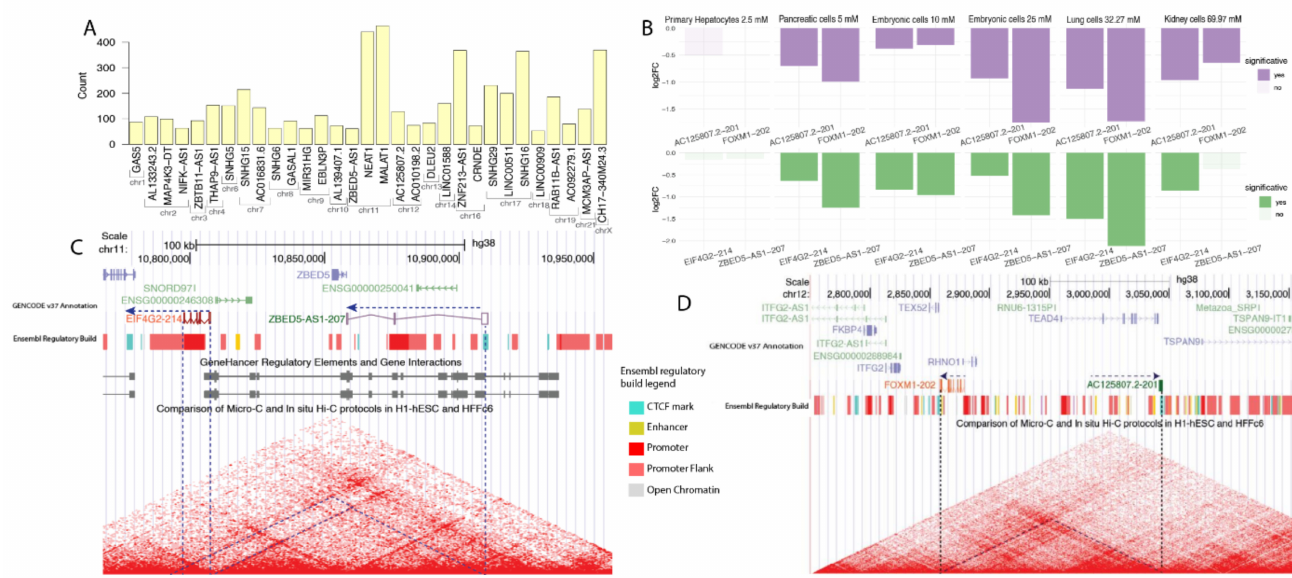
Figure 4. ( A ) total transcript counts in the 1 mb to each side region around the lncRNA for the 36 lncRNA selected for further analysis. ( B ) expression bar plots of the lncRNA isoform—transcript pairs which passed on the correlation cutoff (corr > 0.8 and p -value < 0.01) and on the genomic distance cutoff (1 mb to each side). On the top, AC125807.2-201 (ENST00000513358.3) and FOXM1- 202 (ENST00000359843.8); on the bottom, ZBED5-AS1-207 (ENST00000664276.1) and EIF4G2-204 (ENST00000530211.6). Significance is computed as values inferior to 0.05. ( C ) Genomic region of around 300kilobases in chromosome 12. Tracks: GENCODE v37 annotation, ENCODE Hi-C, and Ensembl regulatory elements data. ( D ) genomic region of around 150kilobases in chromosome 11. Tracks: GENCODE v37 annotation, ENCODE Hi-C, Genehancer IM-PET, and Ensembl regulatory elements